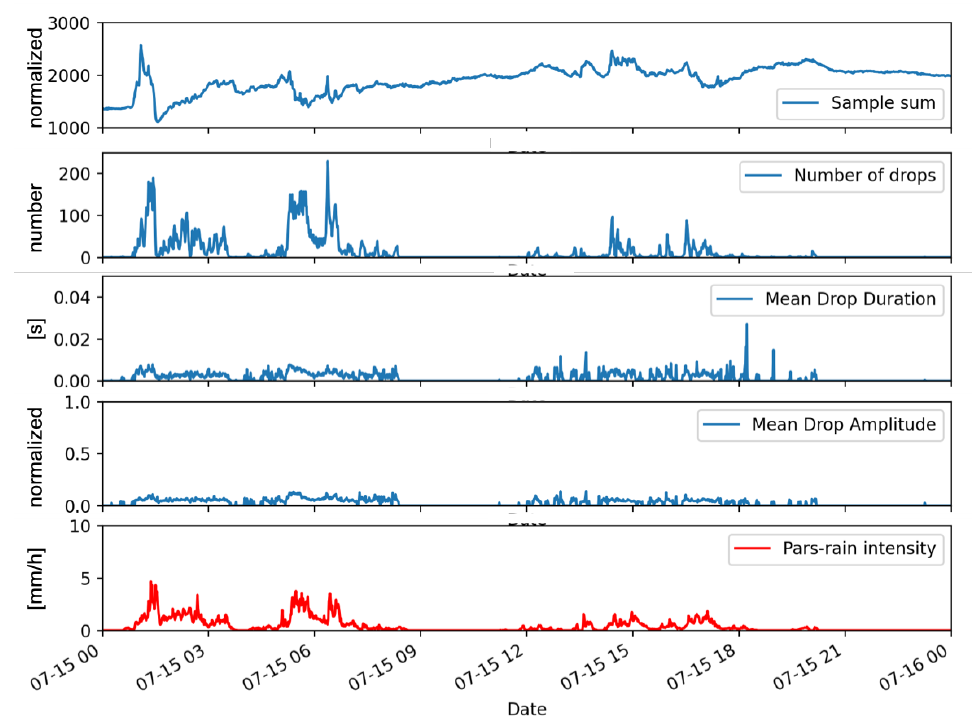
Figure 4. Outputs from the impact disdrometer quantities (graphs in blue) as compared with the 1-minute averaged rainfall intensity obtained by a commercial disdrometer (graph in